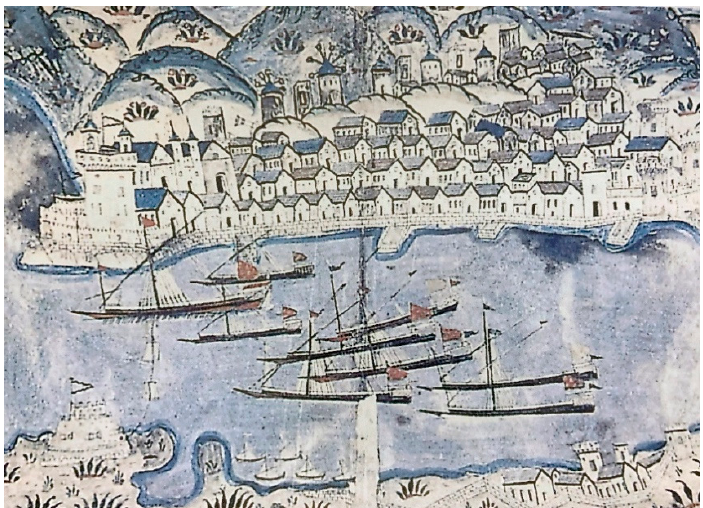
Figure 2. A view of the port of Marseille by a Turkish artist, possibly Matrakçi Nasuh, in 1563. Print courtesy of the Regis family. Public domain.